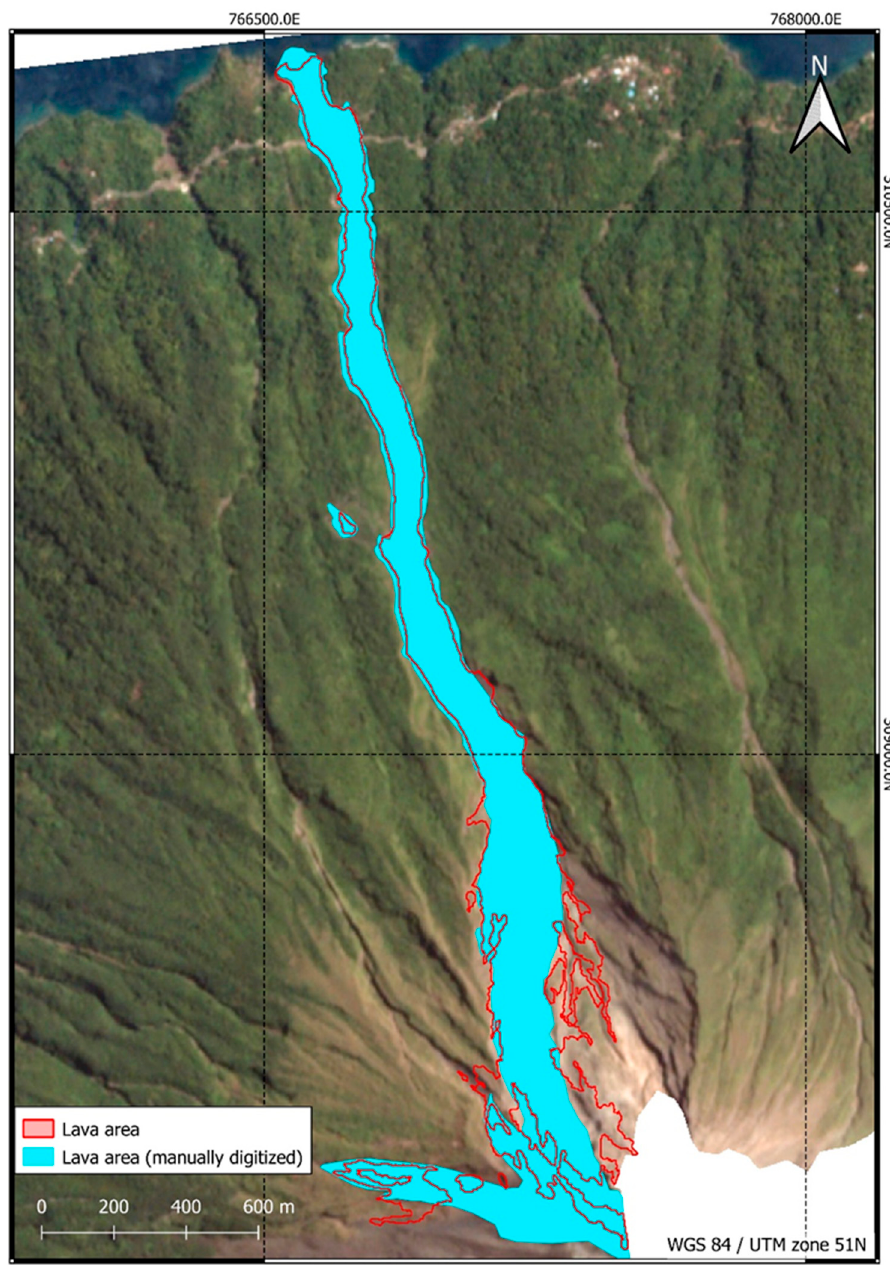
Figure 12. Validation of lava area derived from OBIA methodology based on TanDEM-X drainage model (red) and manually digitized lava area (light blue). The manual digitization took place based on the PlanetScope post-scene (4 May 2019). In the lower area, the edge areas were manually captured in a slightly coarser way. In contrast, the lava delta in the sea was mapped better by manual digitization. In the upper area, the potential misclassifications in the E of the lava flow were omitted. In addition, there is the connection of the small lava flow in the WNW to the North Crater. In the sub-areas of the unvegetated area, manual digitization was difficult to perform because there was little contrast with the background. Accordingly, the optical validation of the lava flow from the OBIA method is given only qualitatively.